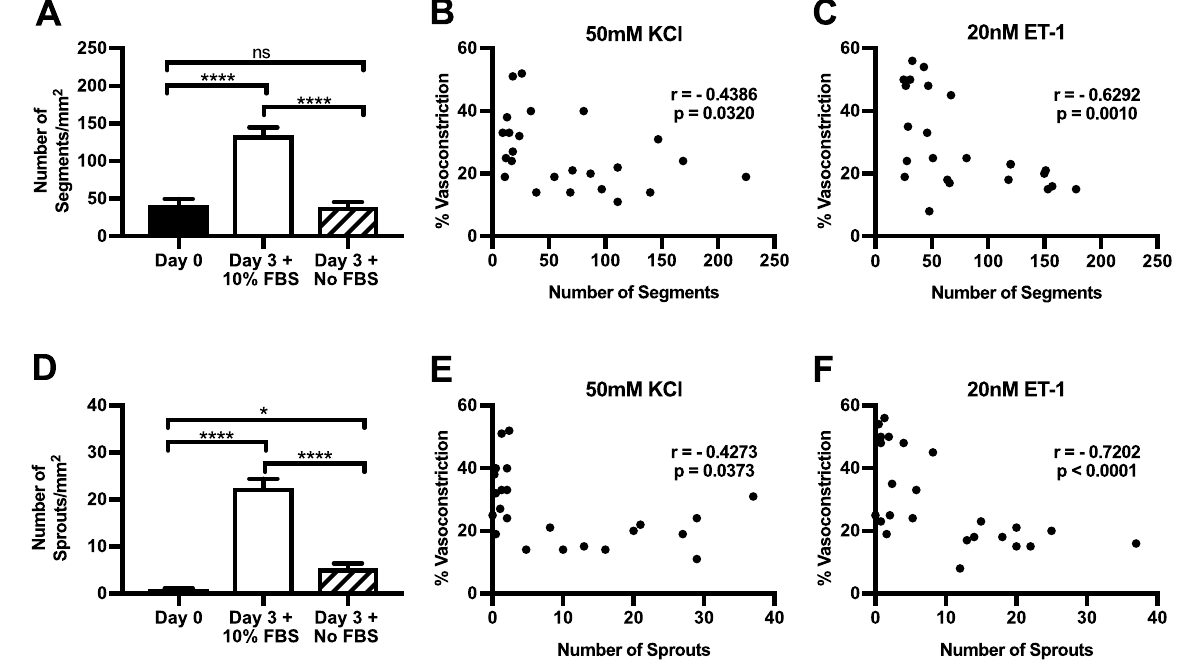
Figure 6. Assessment of the relationship between angiogenesis and vasoconstriction responses. ( A–F ) Evaluation of vascular vessel segments ( A–C ) and vessel sprouts ( D–F ). Correlation of segments ( B , C ) and sprouts ( E , F ) from vasoconstriction responses to 50 mM KCl and 20 nM ET-1. * and **** indicates a significant difference of p < 0.05 and p < 0.001 respectively, by One-Way ANOVA and Student-Newman-Keuls post hoc method. “ns” Indicates no significant difference (p > 0.05). “r” Indicates the Spearman rank order correlation coefficient. Black, white, and striped bars represent Day 0, Day 3 + 10% FBS, and Day 3 + No FBS groups